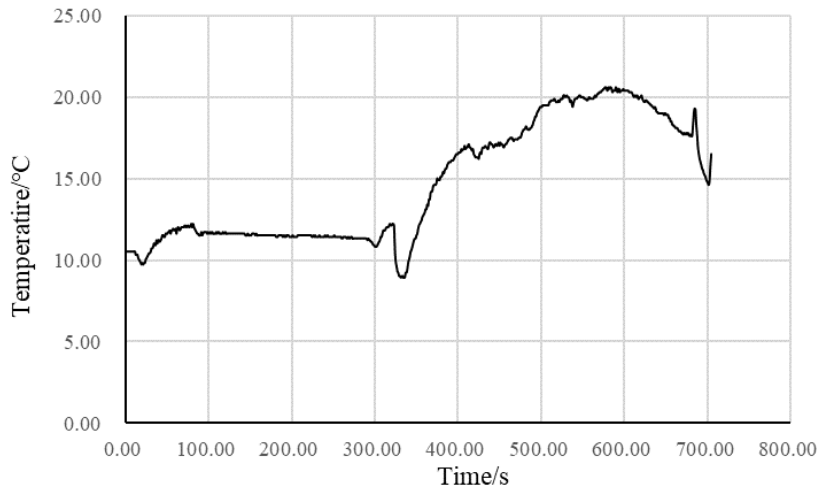
Figure 10. The exhaust temperature variation of the FSDS.